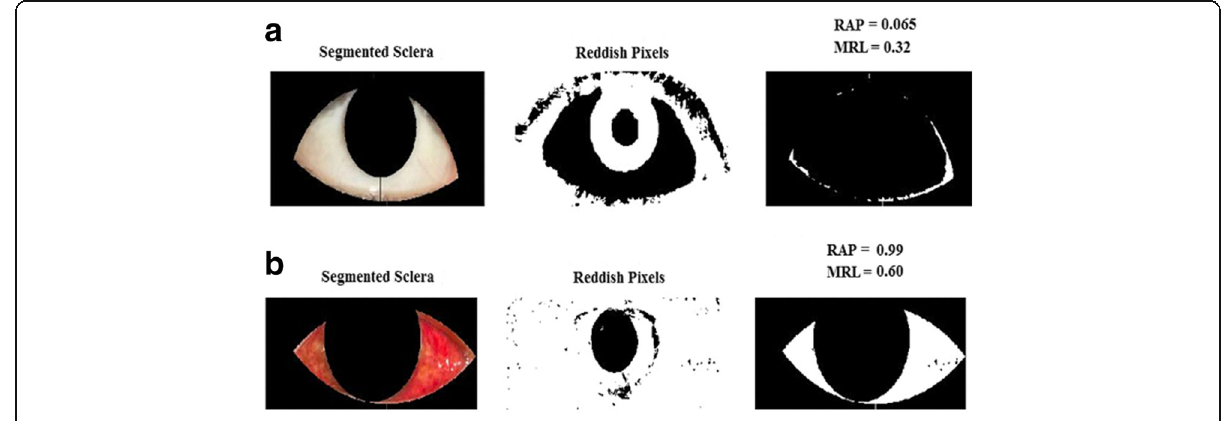
Fig. 9 Results of MRL and RAP. a Normal IOP. b High